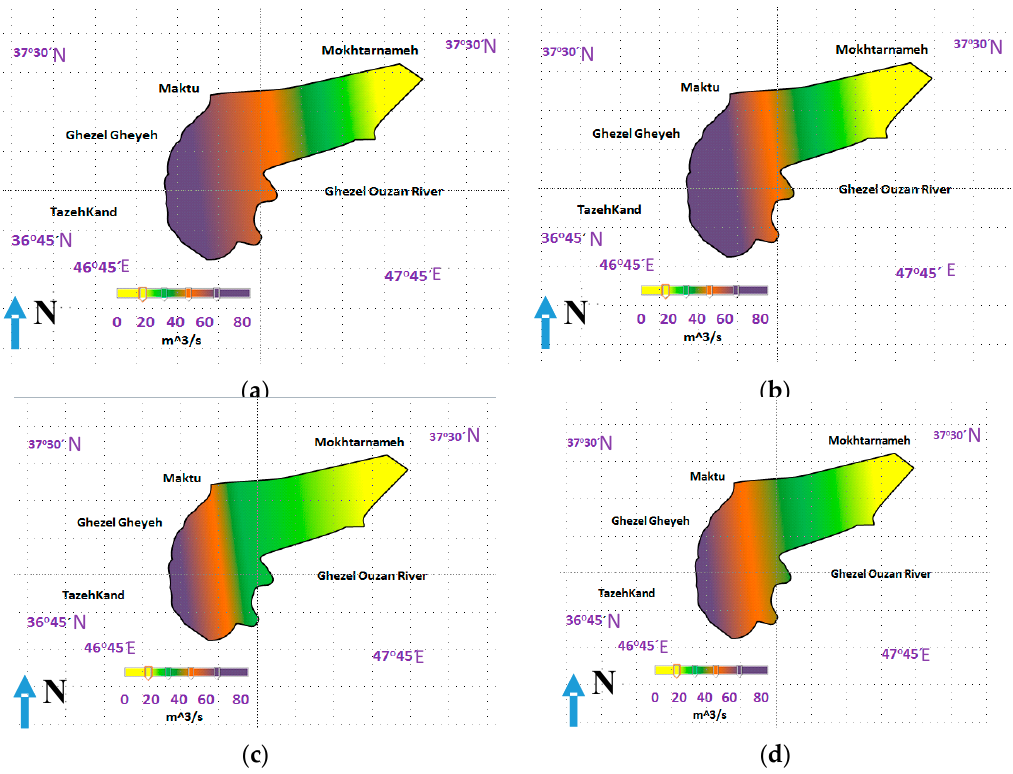
Figure 9. ( a ) spatial streamflow based on summer, ( b ) observed spatial streamflow based on autumn, ( c ) spatial streamflow based on winter, ( d ) spatial streamflow based on spring.